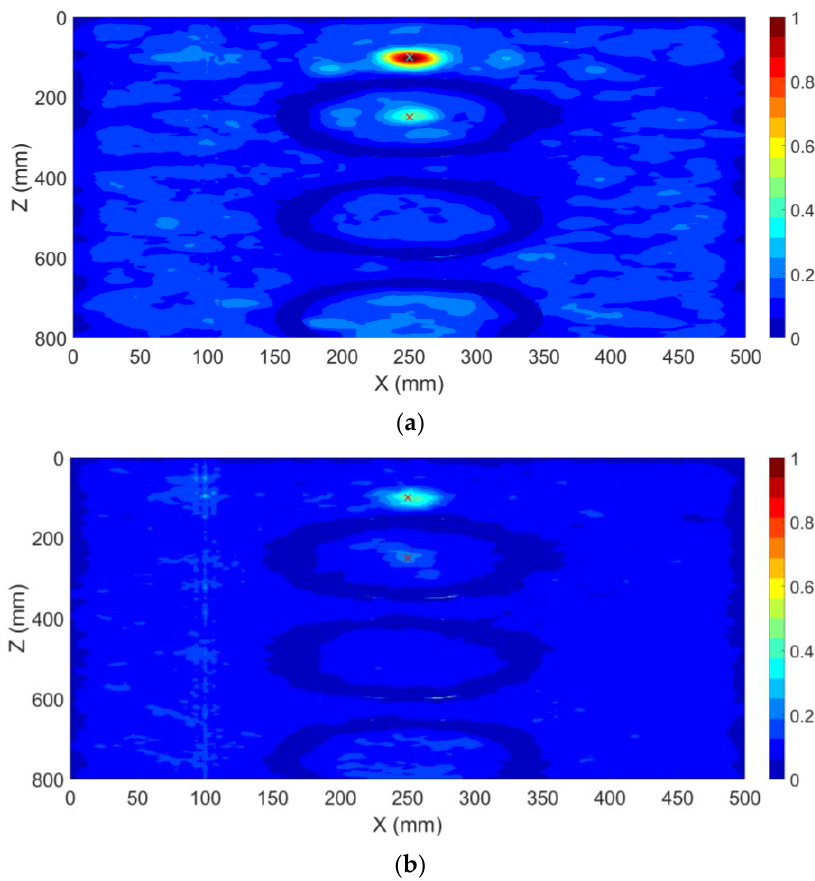
Figure 9. Normalized distribution of the maximum electric field power over the complete simulation time inside the transformer tank in the x-z cut plane (CS #5). ( a ) an SNR of 20 dB is considered and ( b ) an SNR of 10 dB is considered. The active parts of the transformer are included. The ground truth locations of the PD sources (PD1 and PD2) are shown by “+” markers. Only one sensor (S1) is used.